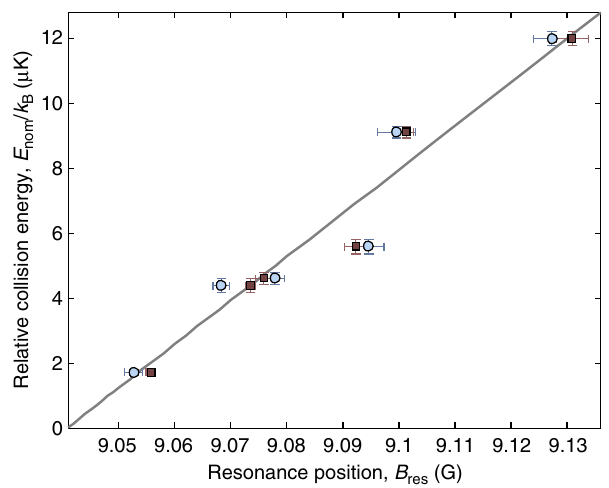
Fig. 6 Energy dependence of resonant magnetic fi eld. Measured resonance positions (abscissa) vs. collision energy (ordinate) as inferred from the zero-crossing of Δ z CM for target clouds ( blue circles ) and projectile clouds ( red squares ). The zero-crossings were extracted from weighted curve fi ts of Δ z CM using a pseudo-Voigt distribution (see “ Methods ” and Fig. 5). Horizontal error bars denote the 1 σ -level con fi dence bound for fi tted values of B res . Vertical error bars are the standard error for our calibrated collision energies. The solid line shows the theoretical prediction for the resonant